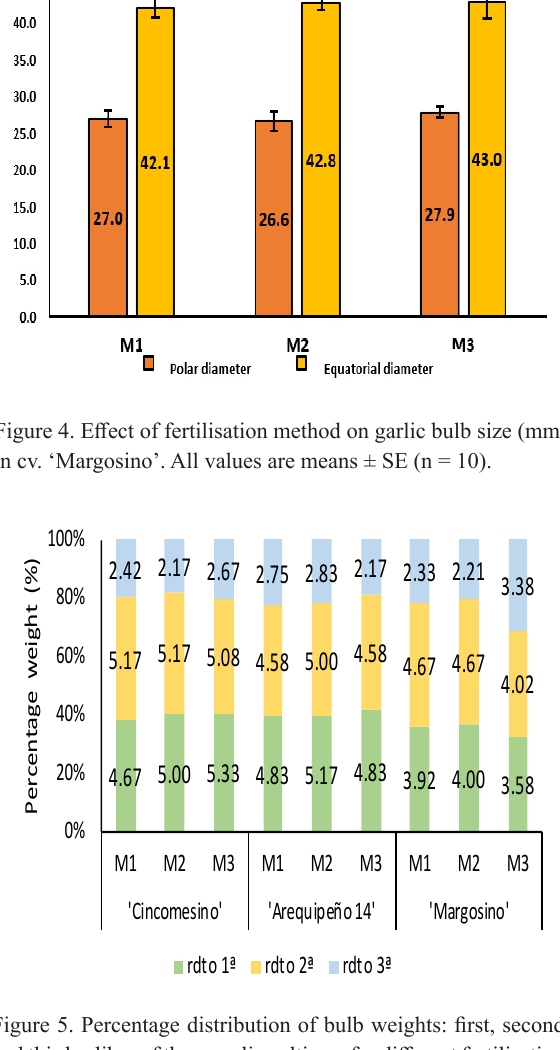
Figure 5. Percentage distribution of bulb weights: first, second and third calibre of three garlic cultivars for different fertilisation methods